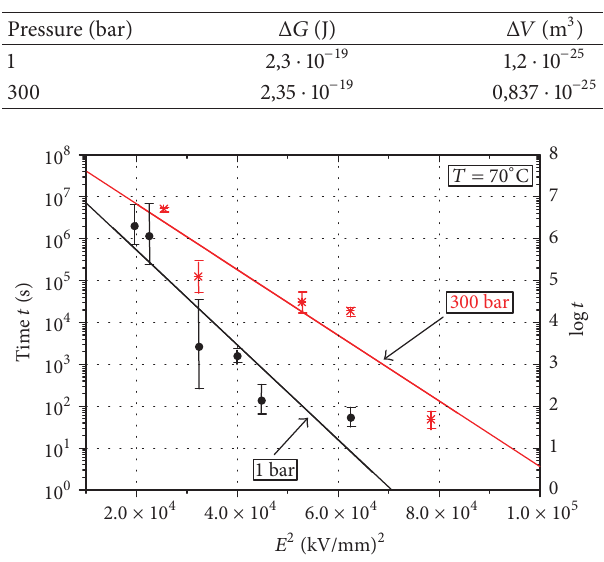
Figure 5: Representation of the experimental data of the XLPE at 70 ∘ C, according to Crine’s